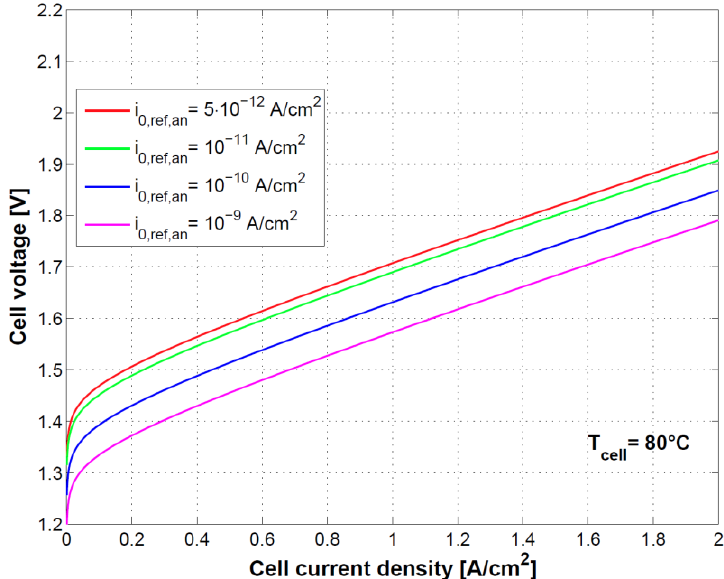
Figure 8. Impact of anode exchange current density on cell polarization curve.